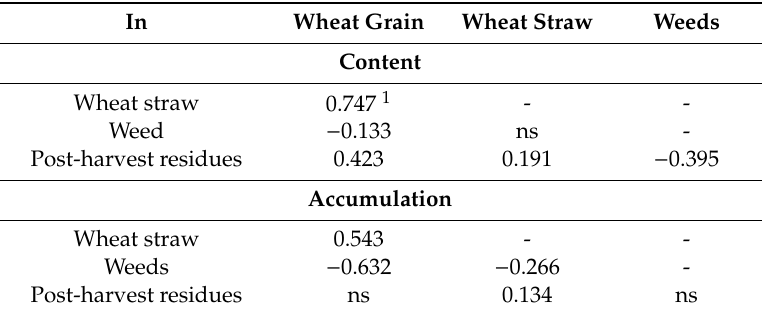
Table 9. Relationship between P content of individual plant biomass parts and between P accumulation in these parts—simple correlation coe ffi cients.